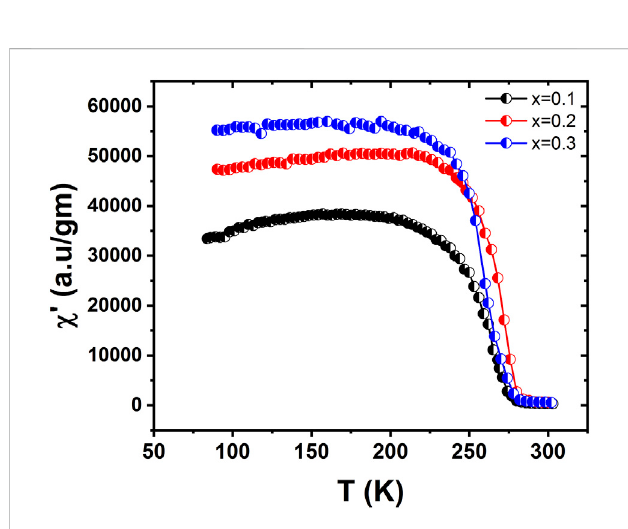
FIGURE 7 Variation of the in-phase of ac susceptibility as a function of temperature for La 1-x Ca x MnO 3 , where x = 0.1, 0.2, or 0.3.